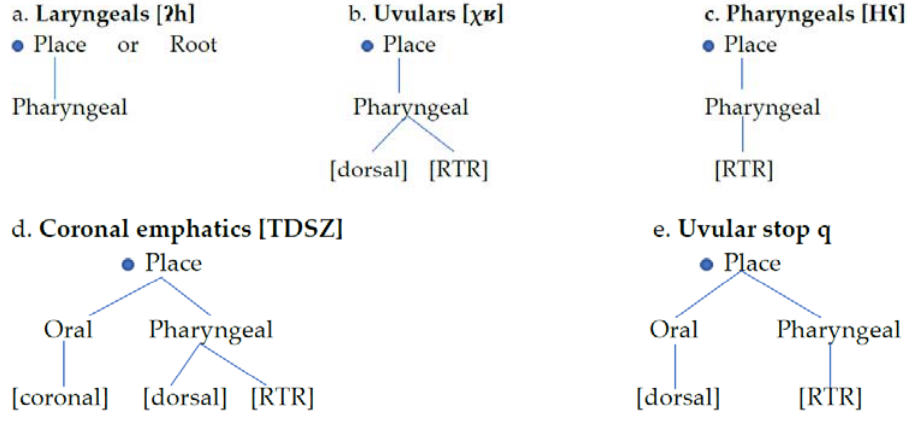
Figure 6. Representation of gutturals (Rose 1996, p. 80).